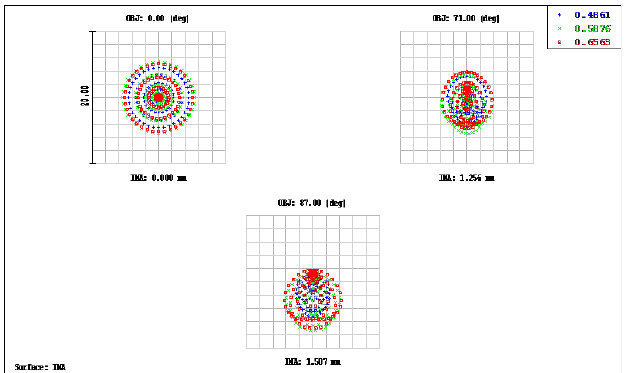
Figure 10. The spot size of a miniaturized wide-angle fisheye lens using a polymethyl methacrylate (PMMA) aspheric lens. The image also shows the RMS spread of the images at three field angles of 0°, 71°, and 87°. The blue, green, and red dots represent wavelengths of 0.4861, 0.5876, and 0.6563 μm, respectively.